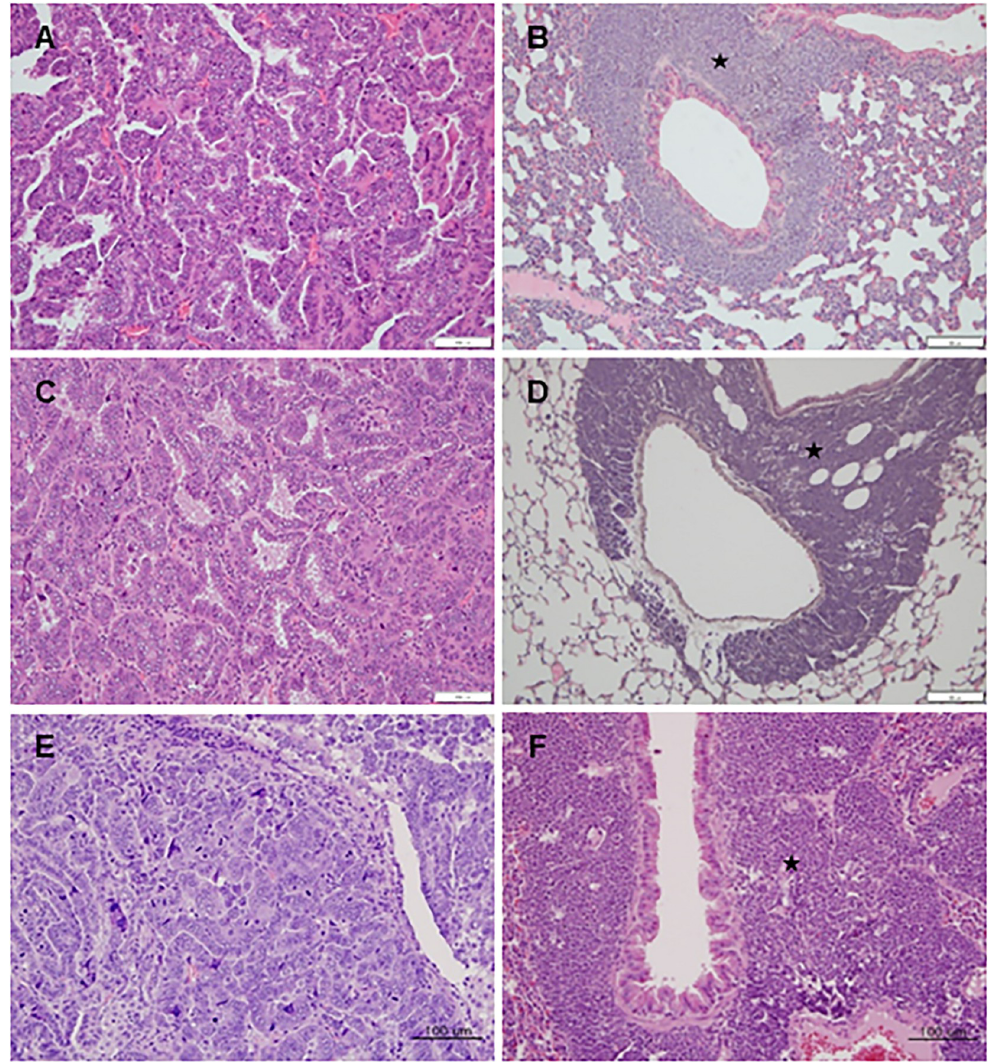
Fig 4. Representative images of histopathological lesions of adenocarcinoma and thymic malignant lymphoma (TML) in the lungs. (A), (C), and (E) show adenocarcinoma in the lungs of the FVB-p53 +/- mice of the 25, 50, and 75mg/kg group, respectively. (B), (D), and (F) show TML metastasis (black star) in the peribronchiolar or perivascular region of the FVB- p53 +/- mice of the 25, 50, and 75mg/kg group, respectively. Scale bar represents 100 μ m. (Fig 5C). The incidence rates of TML in the thymus of FVB-Trp53 +/- mice were 54.2% and 59.1% in the 50 mg/kg and 75 mg/kg groups, respectively, which were significantly higher than the 0% and 5% in wild-type mice (Fig 5D). Metastasis of TML was observed in 29.2% and 45.5% of FVB-Trp53 +/- mice in the 50 and 75 mg/kg groups, respectively, which was signifi- cantly higher than that in wild-type mice (0% and 5%, respectively) (Fig 5E).